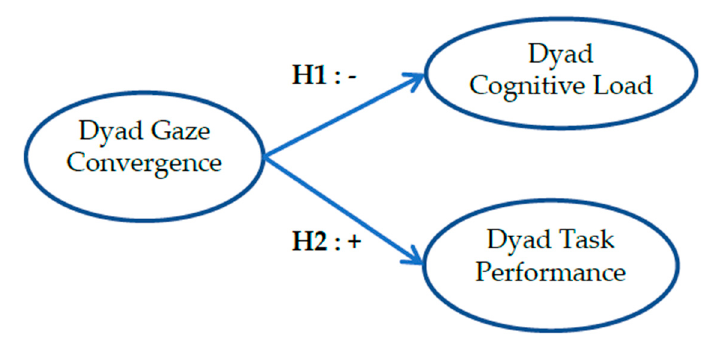
Figure 2. Model for predictive validity of dyad gaze convergence.